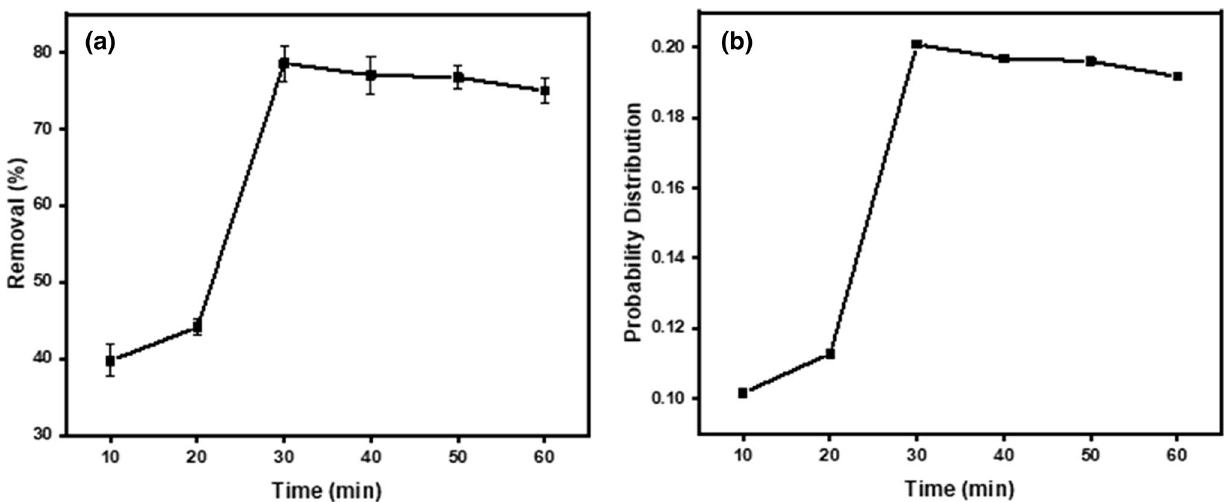
Fig. 6 a Effect of contact time on removal of As(ΙΙΙ) by His-MMt b PDF verification of kinetic